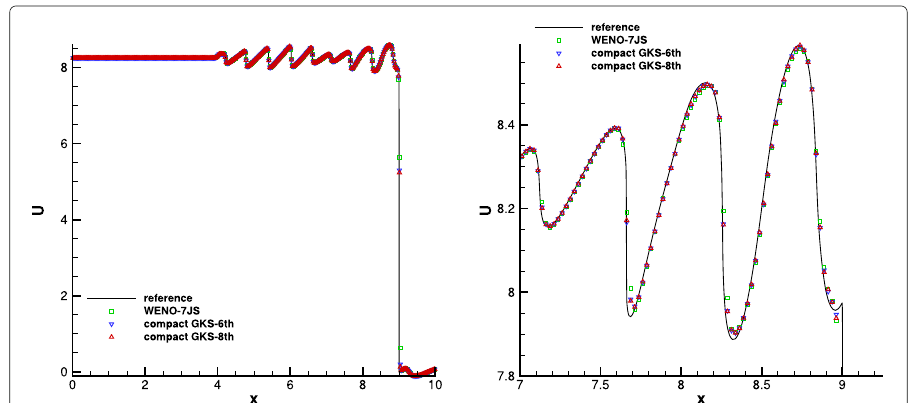
Fig. 11 One-dimensional shock crossing velocity perturbation: the velocity distribution and local enlargement from WENO-7JS non-compact GKS, 6th-order and 8th-order compact GKS at t = 0.8 with 400 mesh